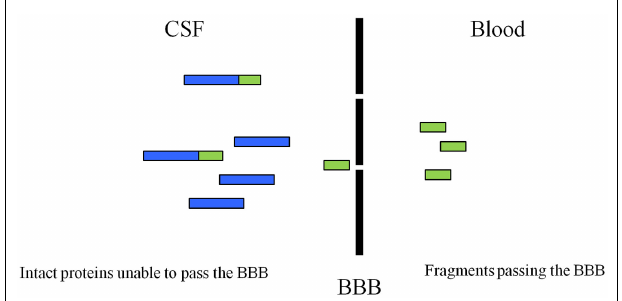
FIGURE 1 | Illustration of how the protein fragments may be able to cross the blood–brain barrier . Protein fragments may have the advantage of crossing the barrier as these breakdown products have a smaller size when compared to the intact protein. Modified from Ref.